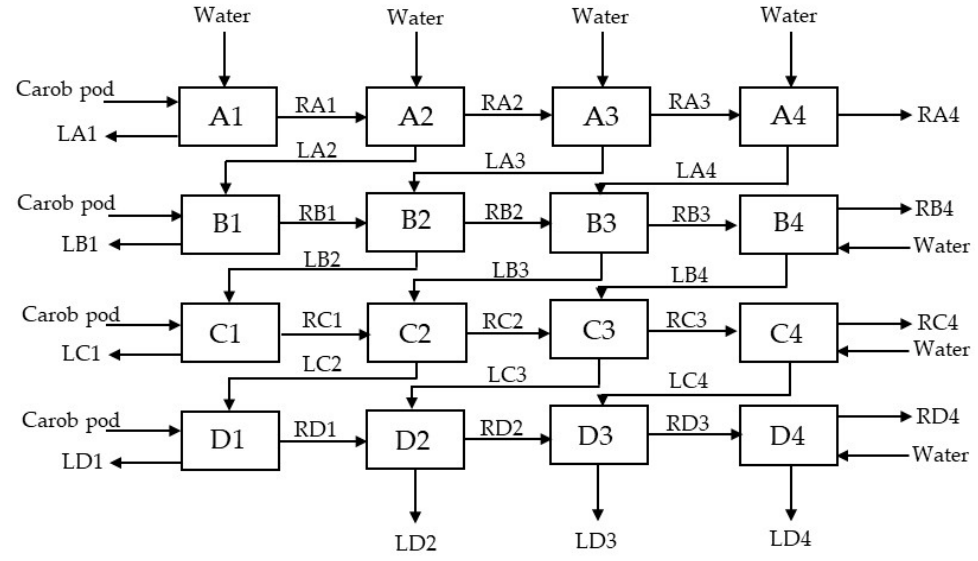
Figure 4. Sugar extraction system with alternate washing steps. L lines represent the flow of the liquid solution. R lines represent the flow of the solid waste.